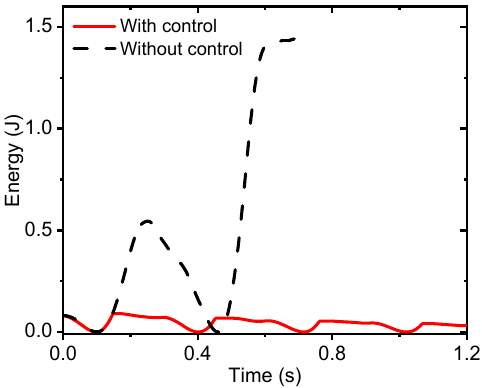
Figure 16. Energy in experiments ( f = 2.2 Hz).